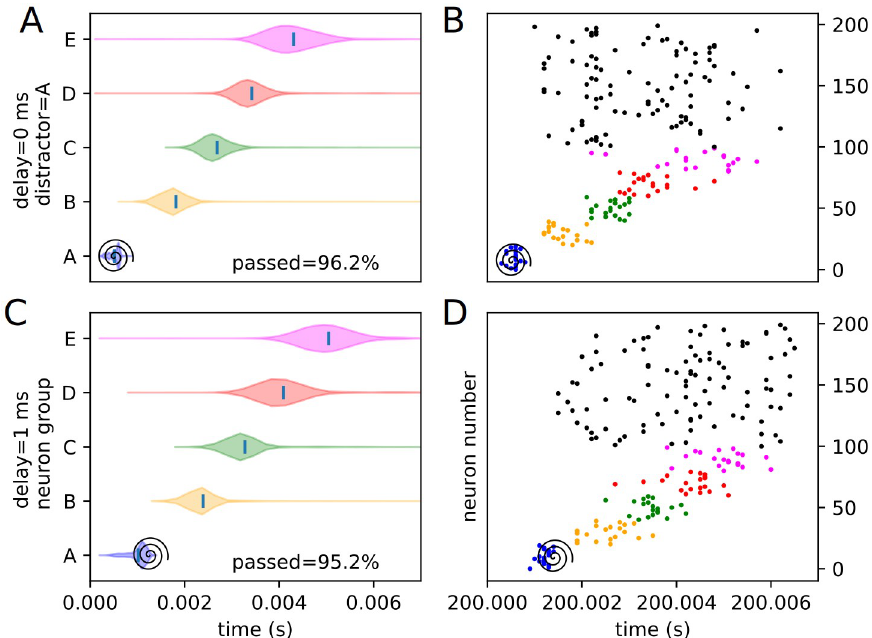
Fig 12. Experimental peak densities for early distractors at position A. Violin plots (densities estimated with a 50 point Gaussian kernel) of the peak times for the first two temporal variants of distraction at position A, with listed percentages of trials passing veto. A raster plot of an example distracted recall is also included. The spiral indicates the location of the distractor. (A) Violin plot for distractor A with 0 ms delay. (B) Example replay for distractor A with 0 ms delay. (C) Violin plot for distractor A with 1 ms delay. (D) Example replay for distractor A with 1 ms delay.